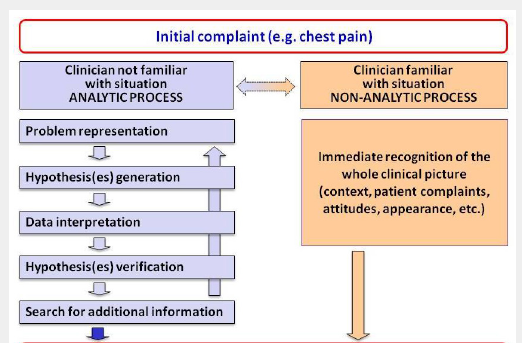
Schematic representation of the dual process of reasoning including immediate recognition of clinical picture (non-analytic process, right boxes) and hypothetico-deductive process (analytic process, left boxes). There is a high level of interaction between